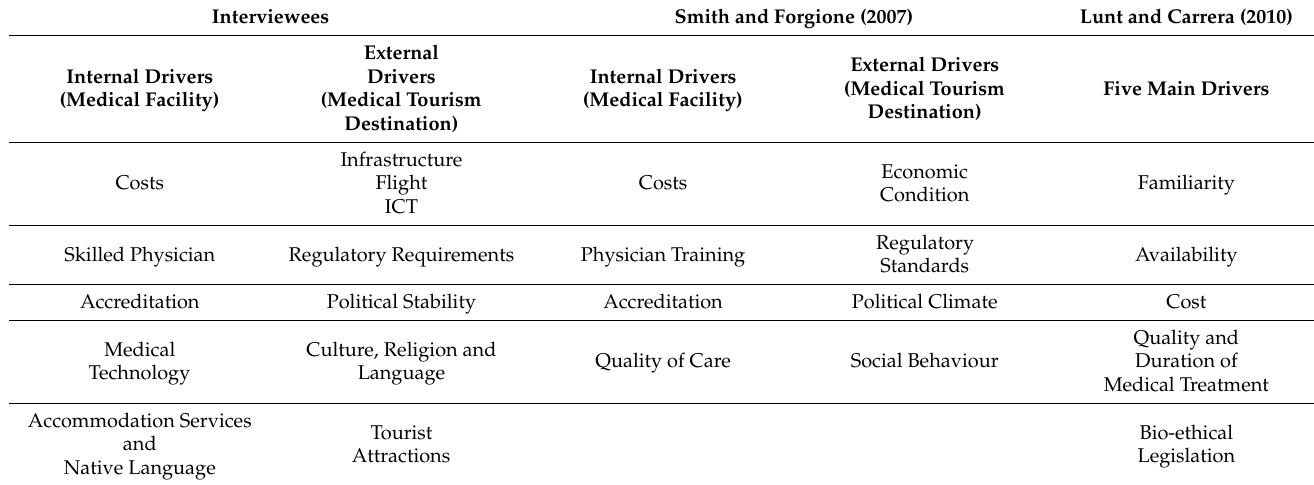
Table 3. The primary factors that motivate medical tourists to travel